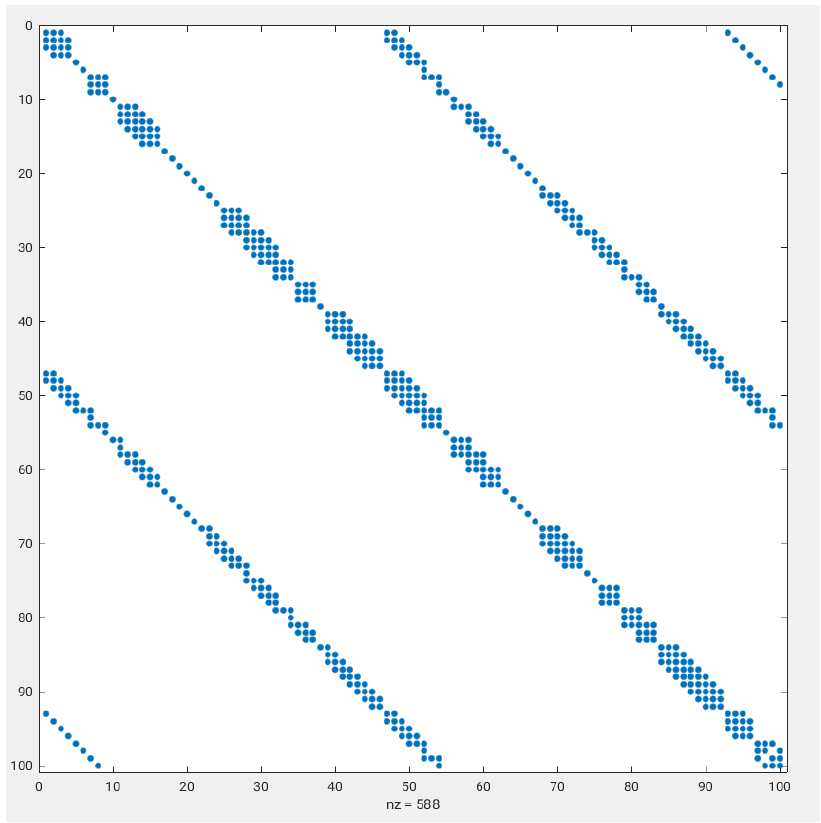
T 2 Id Λ ) . 100 elements of the matrix ( Λ T 2 Id Λ ) . Figure A1. Block-diagonal pattern of the first 100 × 100 elements of the matrix ( Λ Figure A1. Block-diagonal pattern of the first 100 · · × · · Inspired on the simpler block-diagonal structure of the Gauss–Newton version of St-LDDMM proposed in [67], we have compared the performance of NGFs PDE-LDDMM using diagonal, penta-diagonal, and all-diagonal truncations of ( Λ T 2 Id Λ ) . Figure A2 · · shows the DSC metrics obtained by the different methods in NIREP16. The figure shows that the diagonal approximation slightly outperforms the penta- and full-diagonal approxi- mations for both Variant I and II. The performance of the method with the diagonal approx- imation shows an identical distribution between the spatial variants and approximately identical between the BL variants. For Variant I, the performance of Gauss–Newton–Krylov optimization is similar to gradient-descent optimization. However, for Variant II, the performance of gradient-descent optimization is strikingly superior. Table A2 shows the mean and the standard deviation of MSE rel , , and the g (cid:107) (cid:107) ∞ , rel extrema of the Jacobian determinant obtained with the methods. For the spatial methods, gradient descent obtains the lowest MSE rel values. For the BL methods, Gauss–Newton with the diagonal truncation shares the lowest MSE rel values with gradient descent. The Jacobians reach more extreme values for the Gauss–Newton methods. These results break with the trend that we have observed for SSD and NCC-like metrics and open the possibility that, in some cases, gradient-descent finds better performing minima than Gauss–Newton– Krylov and it is, therefore, a preferable